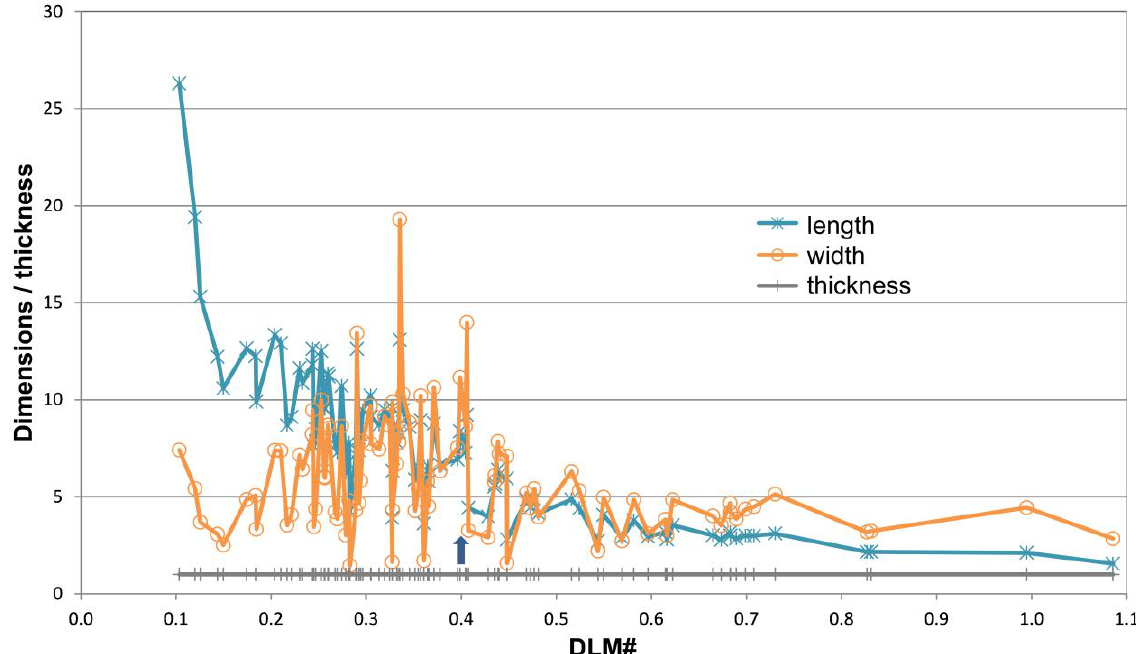
Figure 1: Co-variation of flake dimensions is shown by plotting the behavioural (DLM#) index in relation to major flake dimensions (divided by thickness to illustrate proportionality). An arrow indicates a discontinuity separating marginal flakes on the left from off-margin flakes on the